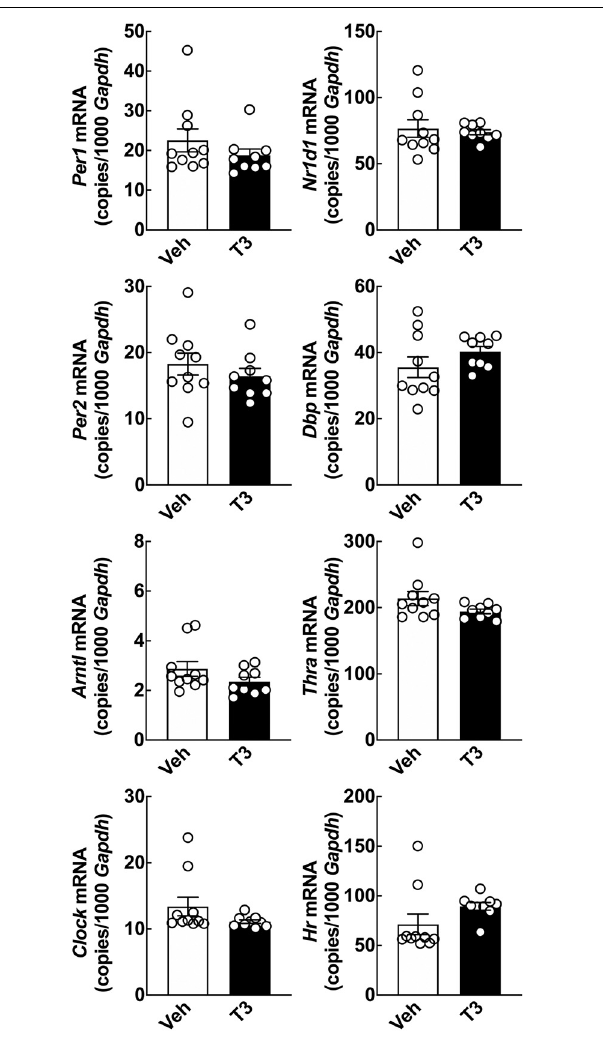
FIGURE 3 | Acute effect of T3 on cerebellar clock gene expression in adult rats determined by qRT-PCR. Adult rats (8 weeks of age) received 0.1 mg/kg T3 by IP injection at ZT5 and were subsequently euthanized at ZT9. Controls received vehicle (Veh). Student’s t -tests did not reveal significant effects in cerebellar clock gene expression between the T3 injected rats and the vehicle group; analyses of Nr1d1 and Dbp included Welch’s correction. n =